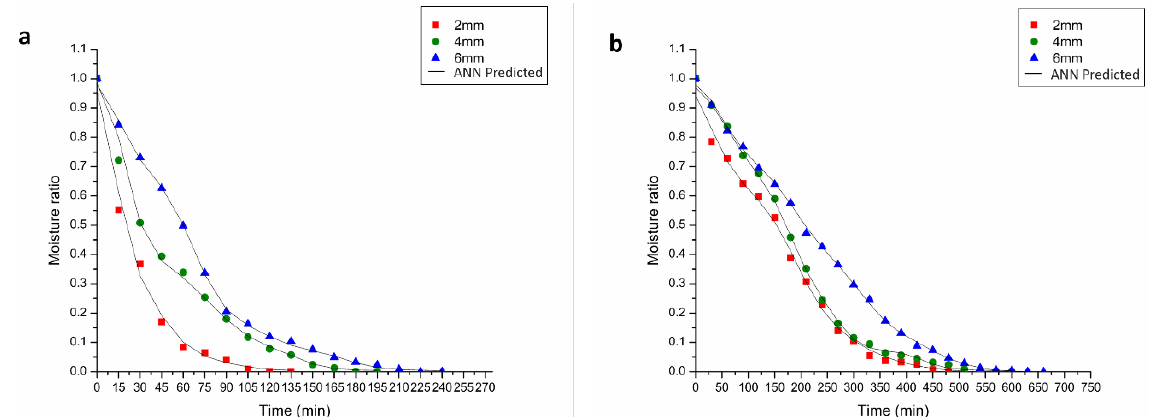
Figure 5. Regression plot obtained using ANN: ( a – d ) RW dryer and ( e – h ) convective dryer.